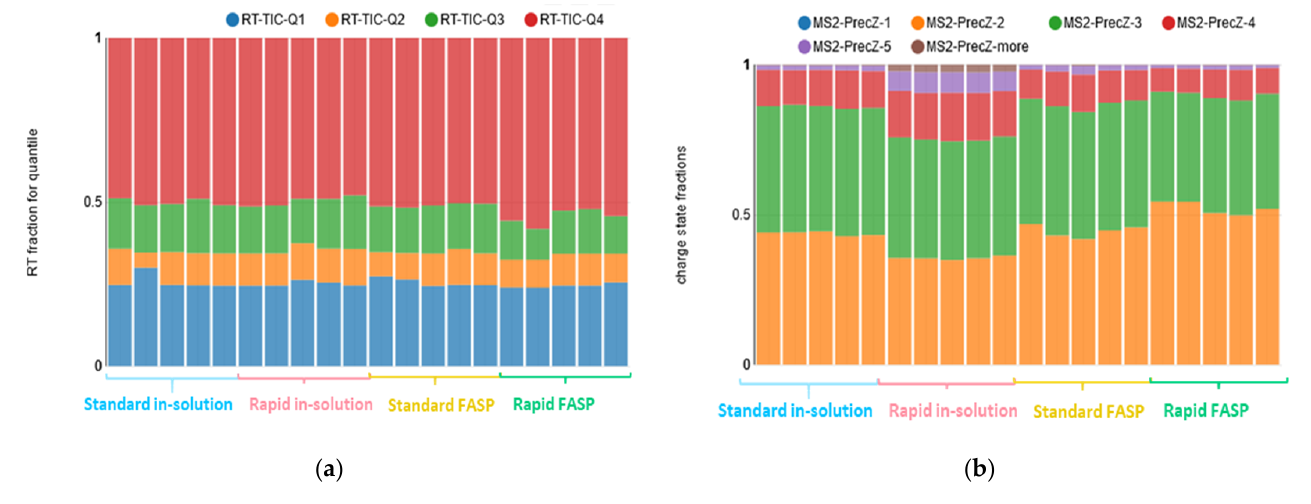
Figure 3. Raw data quality assessment: ion chromatogram and charge state distribution. The simi-larities of the obtained chromatograms were assessed in MaCProQC using ( a ) TIC quantile analysis, where the quantiles reflect the fraction of the retention time (RT) referring to the first (RT-TIC-Q1), second (RT-TIC-Q2), third (RT-TIC-Q3), and fourth (RT-TIC-Q4) quarter of the total run ’ s intensity. Slight shifts were seen for the rapid FASP. Additionally, ( b ) the distribution of the precursor charge states, i.e., +2 (MS2-PrecZ-2), +3 (MS2-PrecZ-3), +4 (MS2-PrecZ-4) etc., was examined and showed less stable distribution for both FASPs.